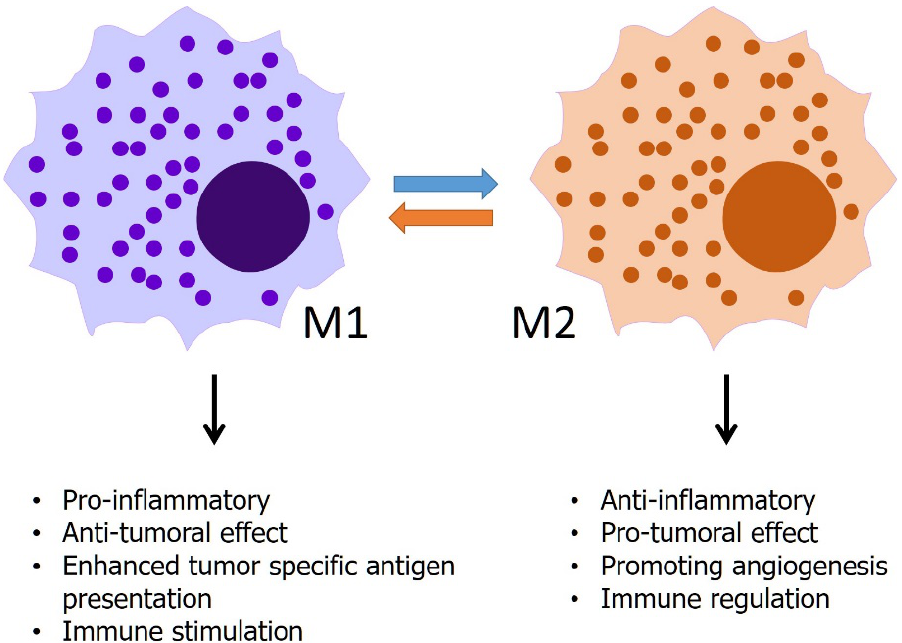
Figure 2. Differential role of M1 and M2 macrophages.